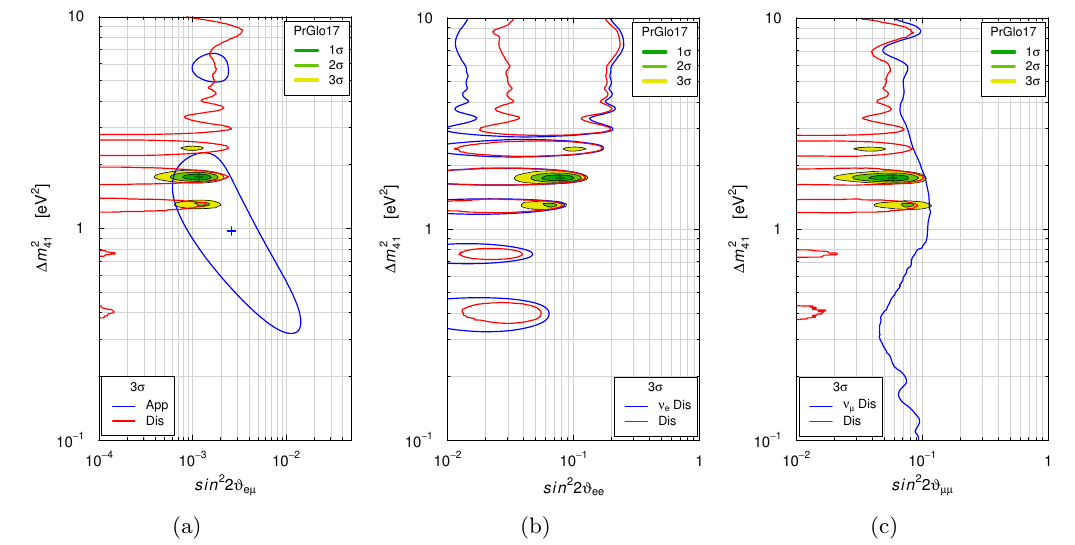
Figure 13 . Allowed regions in the sin 2 2 # e(cid:22) {(cid:1) m 2 (c), planes obtained in the pragmatic 3+1 global (cid:12)t \PrGlo17" of SBL data. There is a comparison with the 3 (cid:27) allowed regions obtained from ( (cid:0) ) (cid:23) (cid:22) ! ( (cid:0) ) (cid:23) e SBL appearance data (App) and the 3 (cid:27) constraints obtained from ( (cid:0) ) (cid:23) e SBL disappearance data ( (cid:23) e Dis), ( (cid:0) ) (cid:23) (cid:22) SBL disappearance data ( (cid:23) (cid:22) Dis) and the combined ( (cid:0) ) (cid:23) e and ( (cid:0) ) (cid:23) (cid:22) SBL disappearance data (Dis). The best-(cid:12)t points of the PrGlo17 and App (cid:12)ts are indicated by